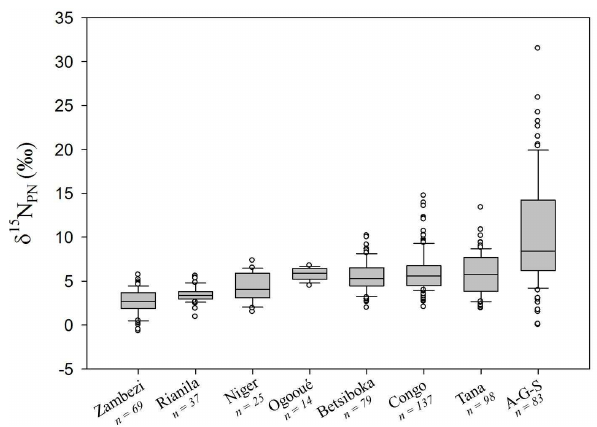
Fig. 10. Box plot of the range of δ 15 N PN data for seven African river catchments. From left to right: Zambezi catchment, Zambia and Mozambique (Zurbrügg et al., 2013, and own unpublished data); Rianila catchment, Madagascar (own unpublished data); Niger catchment, Niger (own unpublished data); Ogooué Catch- ment, Gabon (own unpublished data); Betsiboka catchment, Mada- gascar (own unpublished data); Congo catchment, Central African Republic and Democratic Republic of the Congo (own unpublished data); Tana catchment, Kenya (Bouillon et al., 2009, and own un- published data); and the Athi–Galana–Sabaki catchment, Kenya (data presented